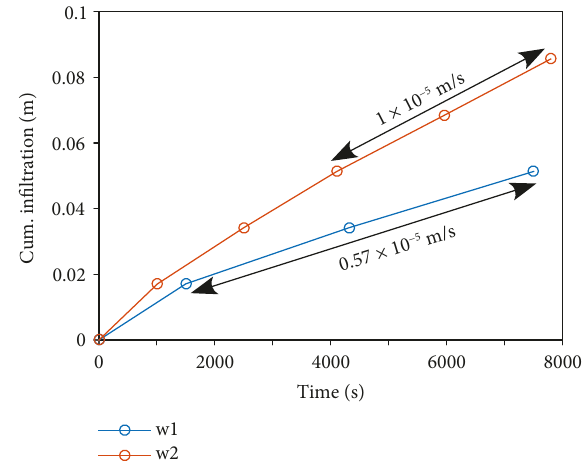
Figure 4: Water in fi ltration tests w1 and w2 (location in Figures 2(b) and 3) and saturated hydraulic